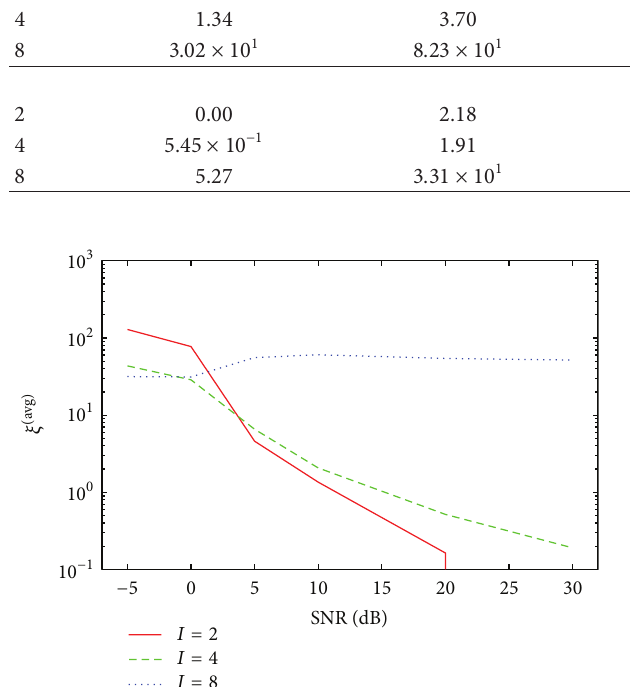
Figure 4: Fully populated array—( 𝑁 = 25 ; 𝑑 𝑥 = 𝑑 𝑦 = 0.5𝜆 ; 𝐼 ∈ [2 : 8] ; SNR ∈ [−5 : 30] dB; 𝑇 = 1 ; 𝐶 = 50 )—behavior of the